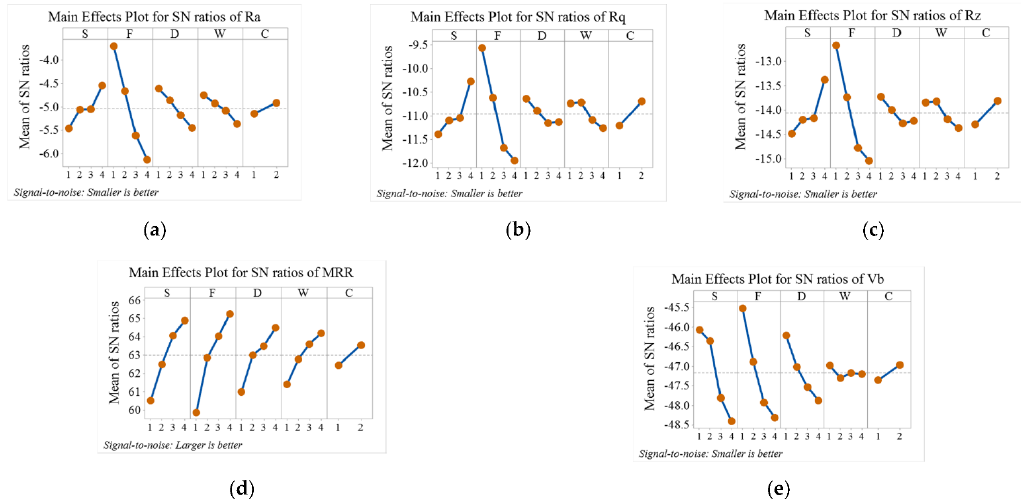
Figure 9. Main effects plots for the SN ratios of ( a ) Ra, ( b ) Rq, ( c ) Rz, ( d ) MRR, ( e ) V b .